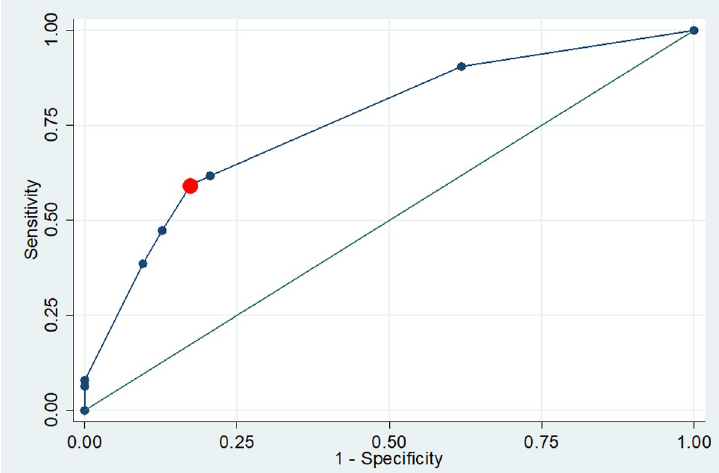
Fig 1. ROC curves–plot of sensitivity versus 1-specificity values for the model: Bilateral CTS score = 0.1 + (1.4 x thenar muscle weakness) + (1.9 x bilateral symptoms) + (0.9 x AGE � 45 yrs). Scoring: thenar muscle weakness: no = 0, yes = 1; Bilateral symptoms: no = 0, yes = 1; and age � 45 years: no = 0, yes = 1. The best cutoff score was 2.0.